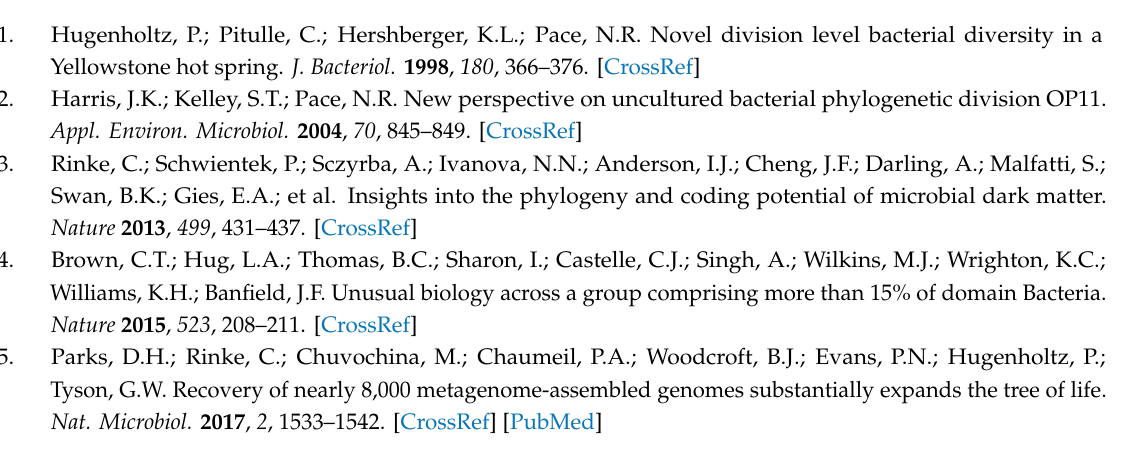
Figure S1: Diagram showing the AT skew and calculated cumulative AT skew across the Ch65 genome; Table S1: Average amino acid identity between Ch65 genome and phylogenetically related members of the order UBA1400; Table S2:. Environmental 16S rRNA gene sequences related to